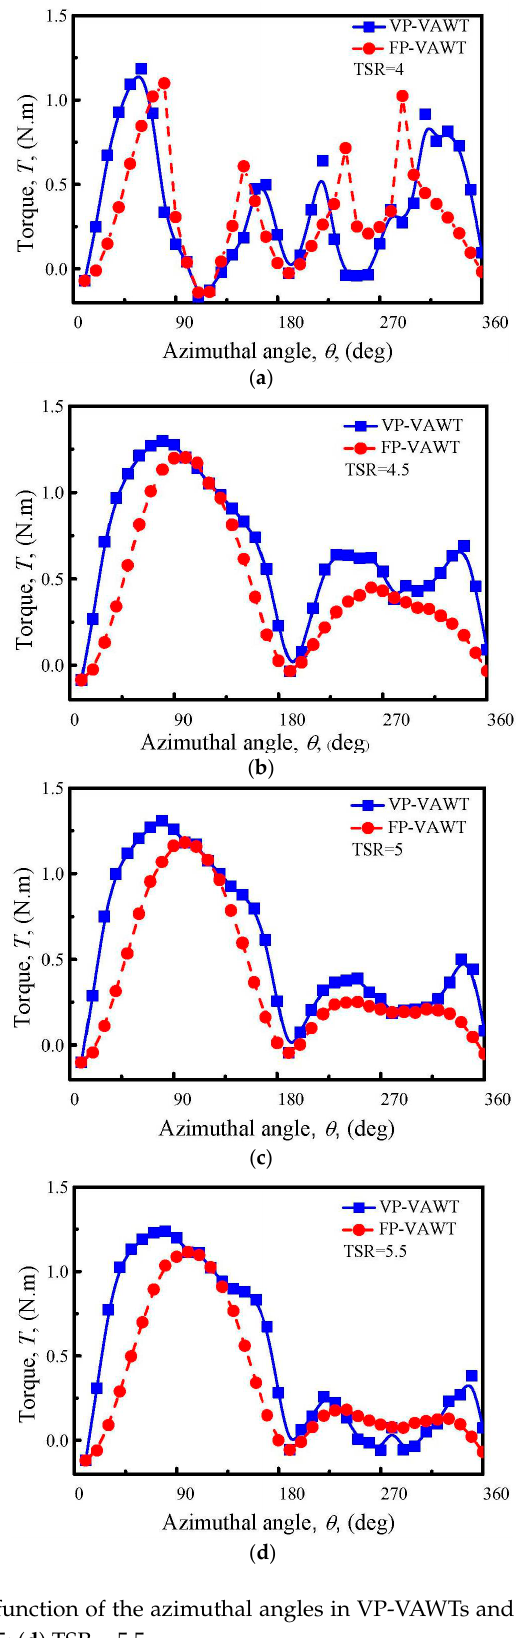
Figure 13. Torque as a function of the azimuthal angles in VP-VAWTs and FP-VAWTs. ( a ) TSR = 4; ( b ) TSR = 4.5; ( c ) TSR = 5; ( d ) TSR = 5.5. ( b ) TSR = 4.5; ( c ) TSR = 5; ( d ) TSR =